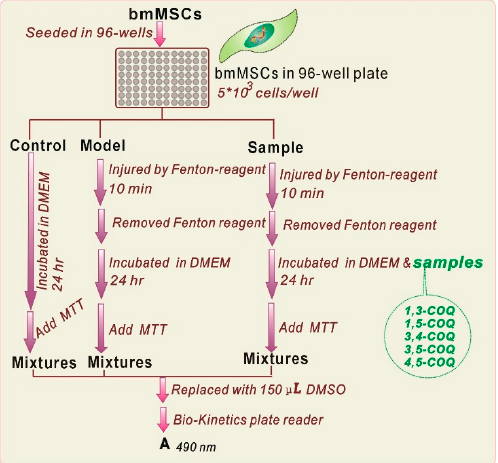
Figure 4. Experimental procedures for the MTT assay. (PE-1420 Bio-Kinetics reader: Bio-Kinetics Corporation, Sioux Center, IA, USA. Each test was repeated in five independent wells. MTT was used at 5 mg/mL (in PBS), and the addition volume was 20 µ L. The addition of Fenton reagent was conducted by injection of FeCl 2 (100 µ M) followed by H 2 O 2 (50 µ